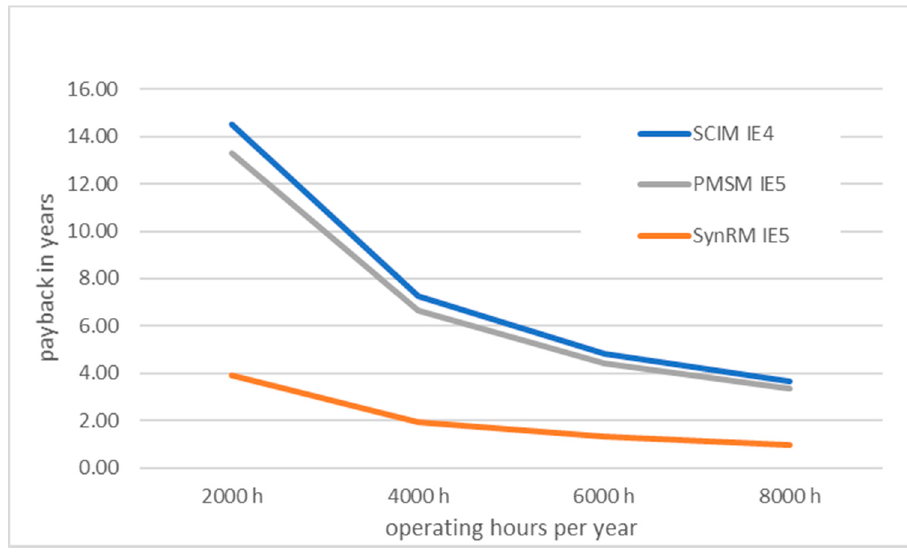
Figure 12. Payback time for SCIM IE4, SynRM IE5, and PMSM IE5, in relation to SCIM IE3, for LP1.